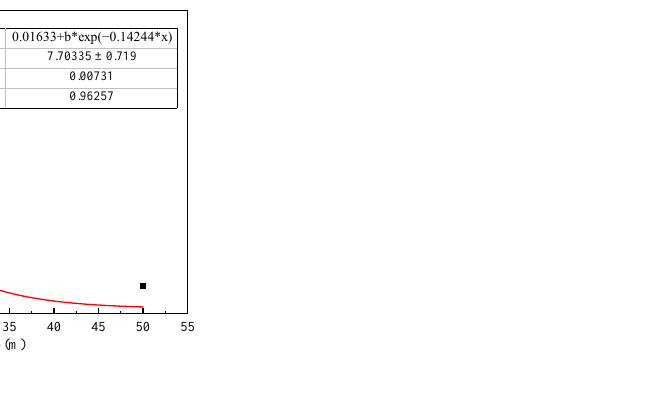
Figure 10. Comparison of predicted and measured results: ( a ) East–west direction; ( b ) south–north direction; ( c ) vertical direction. Table 4. Analysis results of attenuation curve regression.